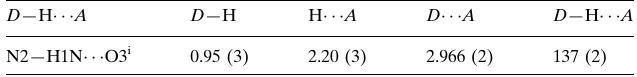
Hydrogen-bond geometry (A˚ , (cid:1) ). D —H (cid:4)(cid:4)(cid:4) A